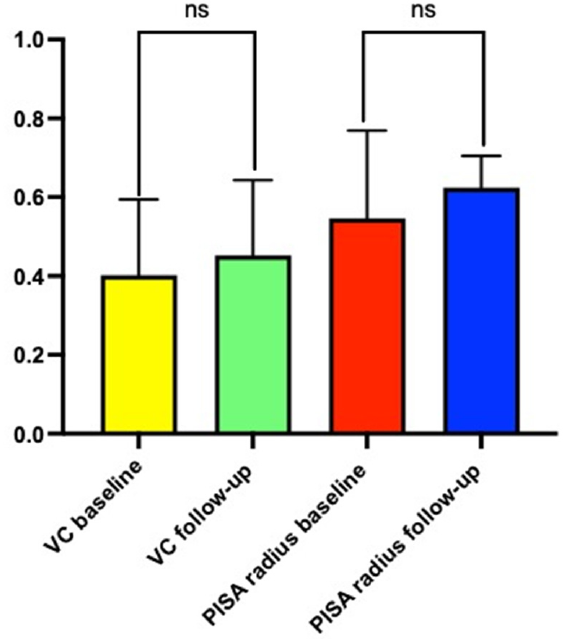
Figure 1. Value of vena contracta and proximal isosurface area radius of tricuspid regurgitation before and after Optimizer ® Smart implantation. VC: vena contracta; PISA: proximal isosurface area radius. ns: non-significance.